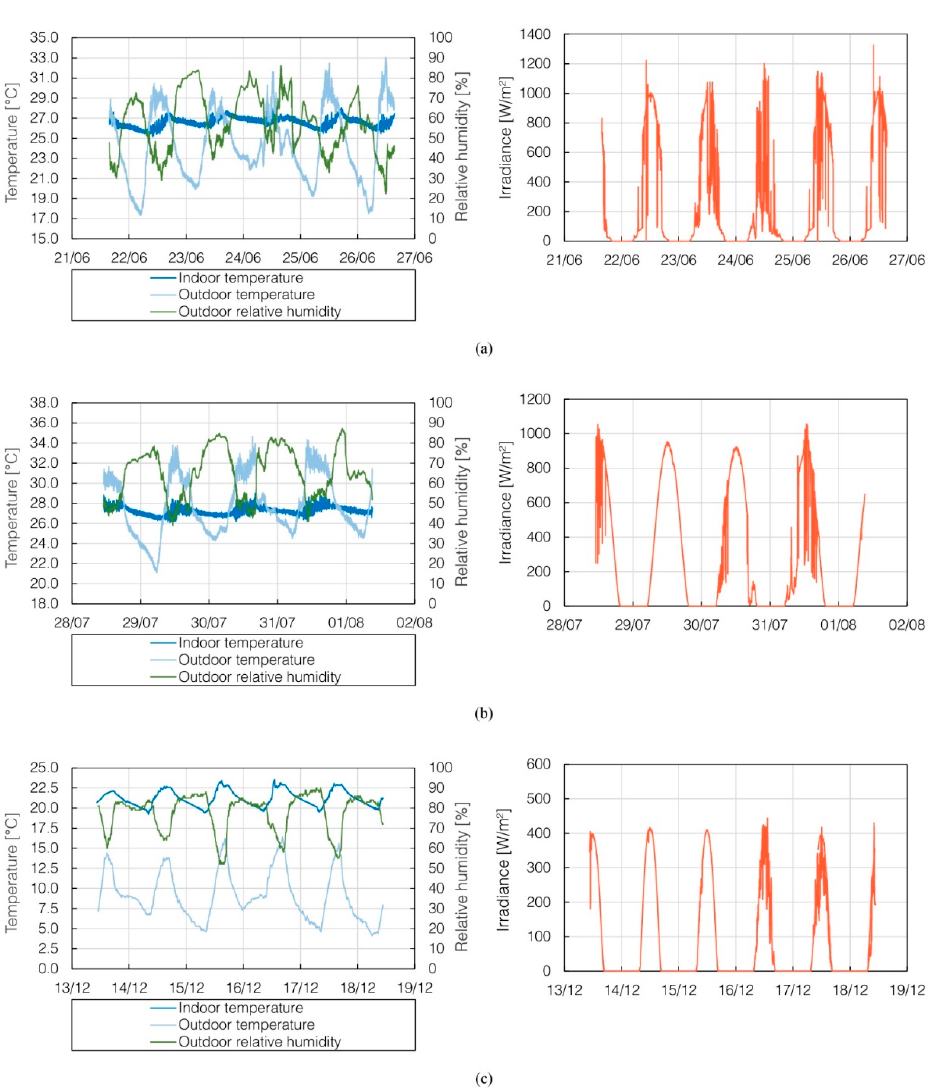
Figure 4. Data acquired during the measurement campaigns. ( a ) data from survey A; ( b ) data from survey B; ( c ) data from survey C.